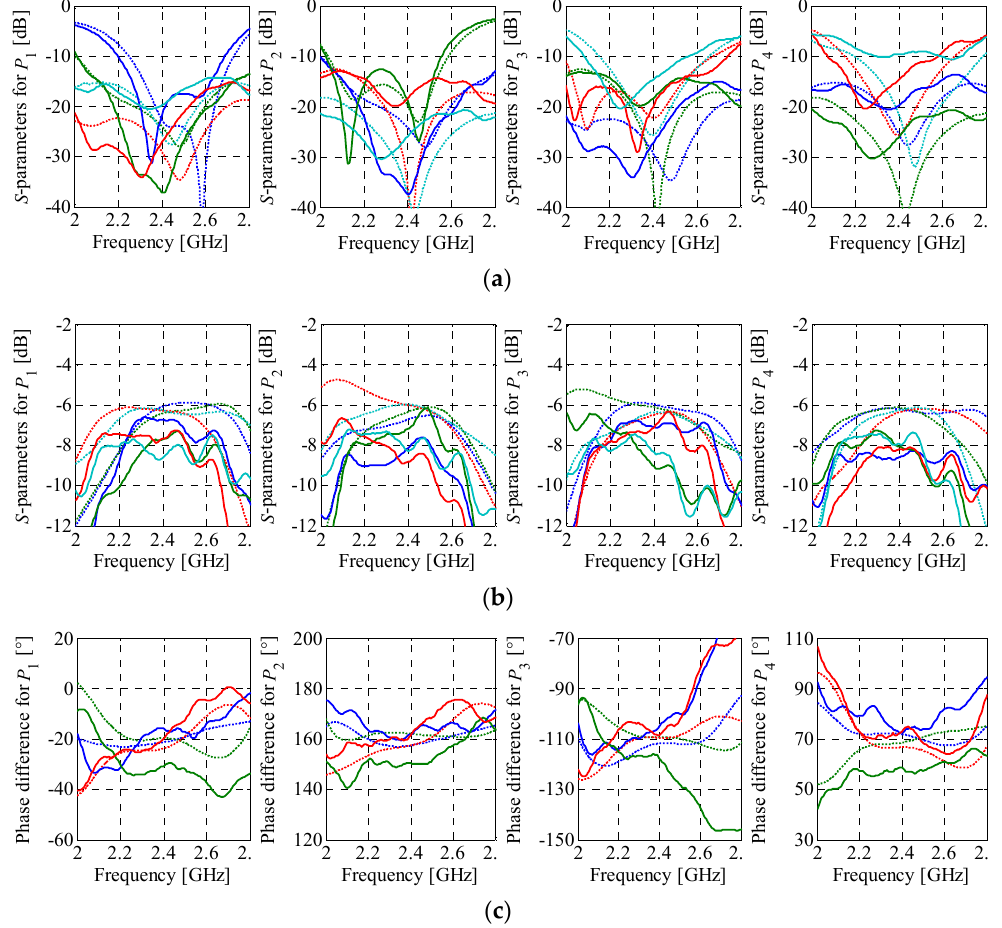
Figure 15. Butler matrix 2: comparison of measurements (––) with EM simulations (···) in terms of reflection/isolation. Here, the EM simulation model does not account for systematic errors.